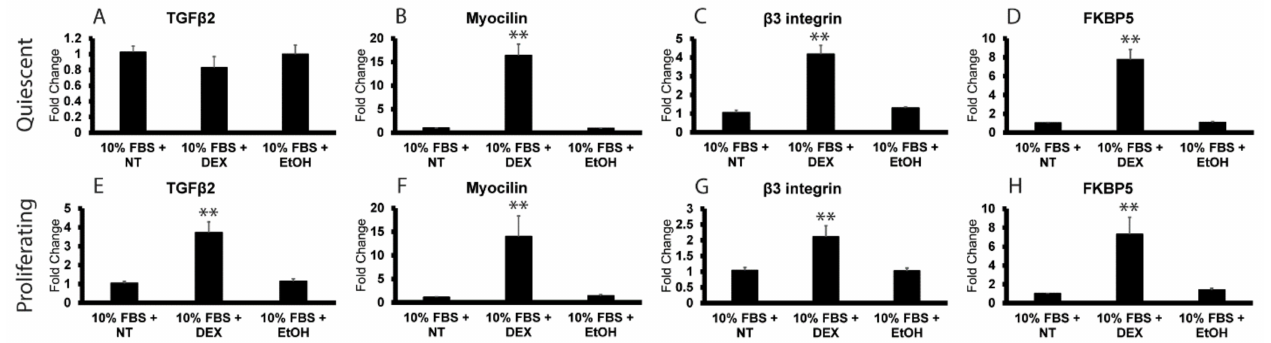
Figure 4. Differential DEX-induced expression of TGF β 2 mRNA in quiescent and proliferating HTM cultures. RT-qPCR analysis was used to determine mRNA levels of TGF β 2, myocilin, β 3 integrin and FKBP5 in HTM cells. The names of the specific mRNAs analyzed are indicated above each panel. Panels ( A – D ) show 7-day post confluent cultures of HTM cells in 10% FBS treated with DEX or EtOH for an additional 72 h or left untreated (NT). Only myocilin, β 3 integrin and FKBP5 increased in response to DEX. Panels ( E – H ) show RT-qPCR results from subconfluent cultures of the same HTM cells in 10% FBS used in panels ( A – D ). All genes, including TGF β 2, showed an increase in expression in response to DEX treatment. n = 5 (from 4 different cell strains). ** p <